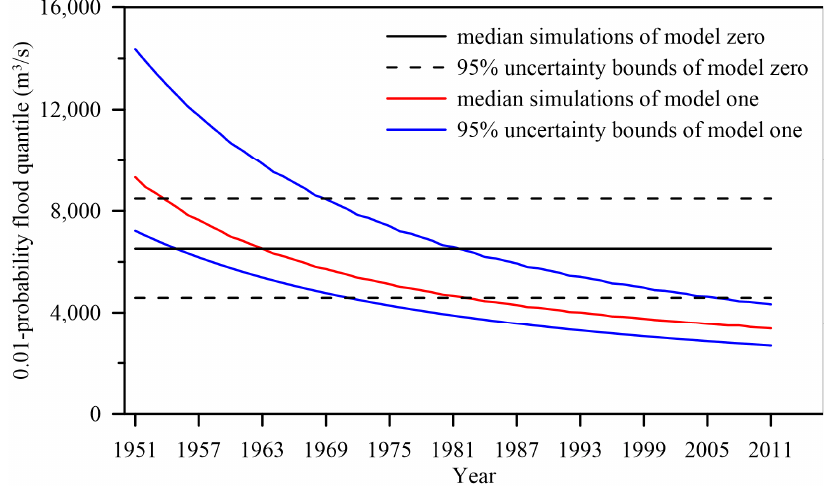
Figure 7. Variation of the estimated annual maximum floods for an exceedance probability of 0.01 based on model zero and one.